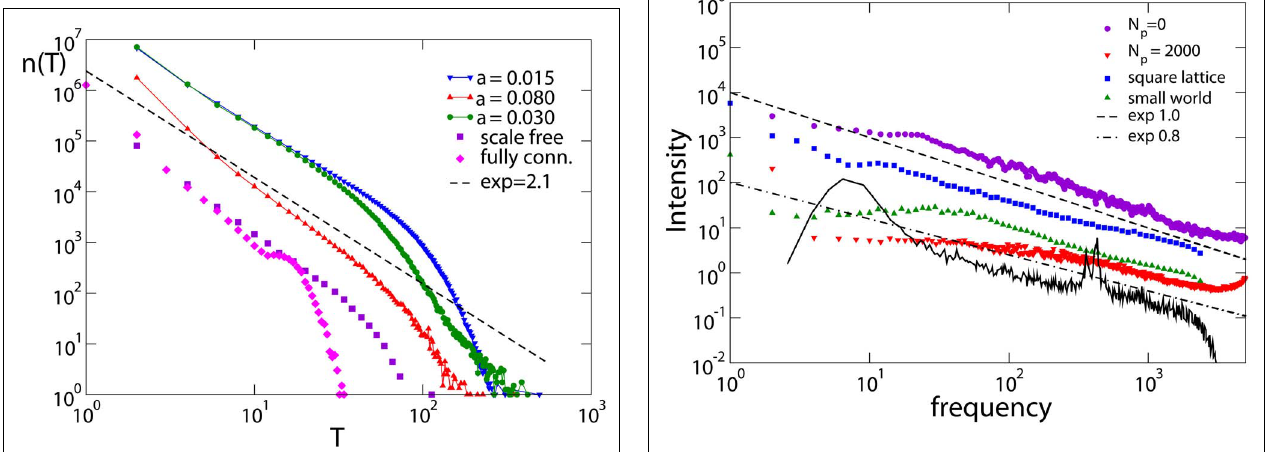
FIGURE 7 |Avalanche duration distribution for different networks with p in = 0.05: the scale-free network ( N = 4000); the fully connected network with N p = 50000; theApollonian networks for different values of α (9th generation, N p = 500) . Data are logarithmically binned.The dotted line has slope 2.1.